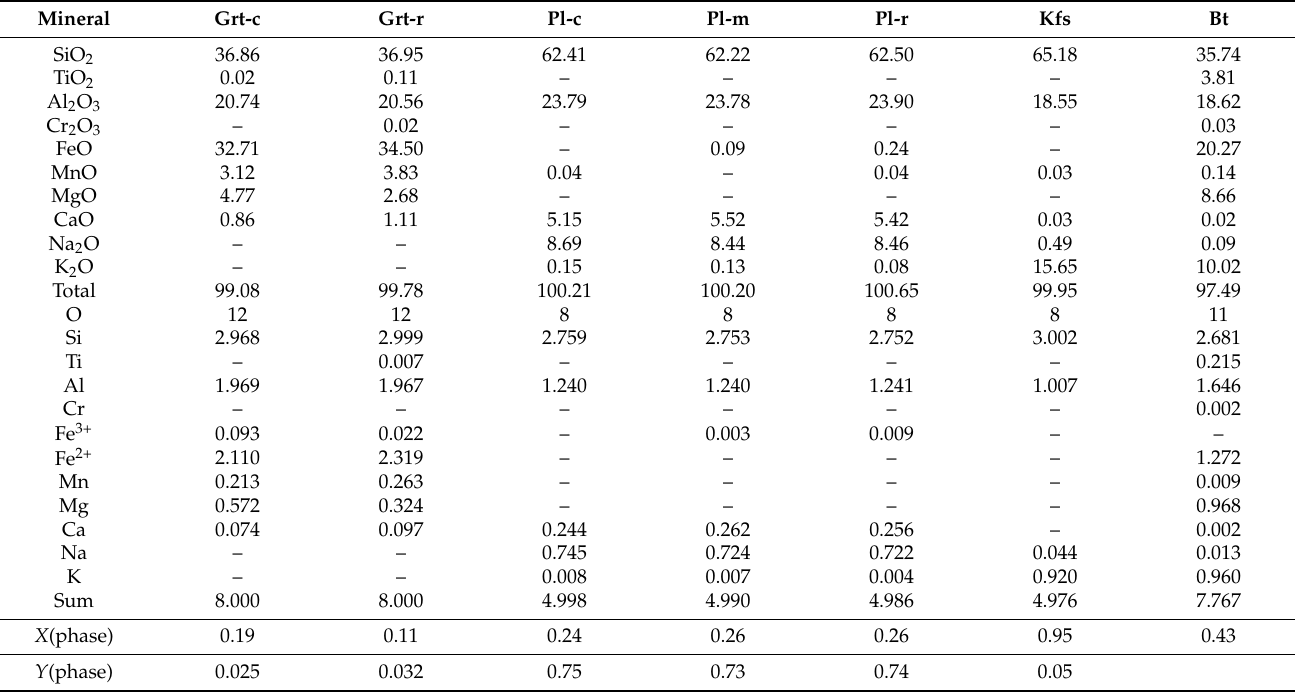
Table 1. Selected microprobe analyses for sample